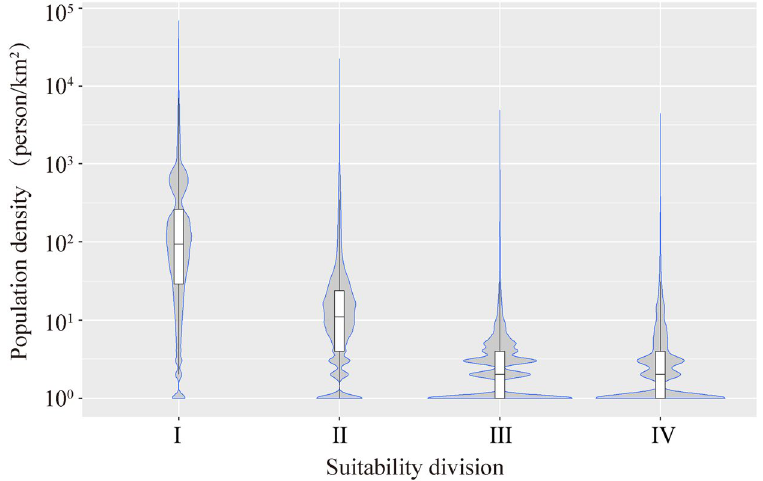
Figure 8. Distribution characteristics of the human population under different regions of environmental suitability classes related to CO 2 capture and storage. Note: The violin plots show the probability density of the data at different values on each side. The bottom, the band inside and top of the box plot inside the violin plot indicate the first quartile, the median and the fourth quartiles of the